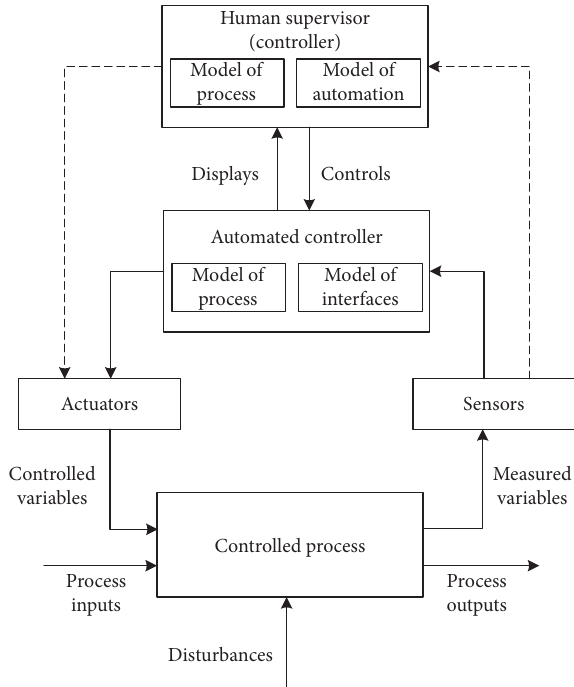
Figure 5: The control model of